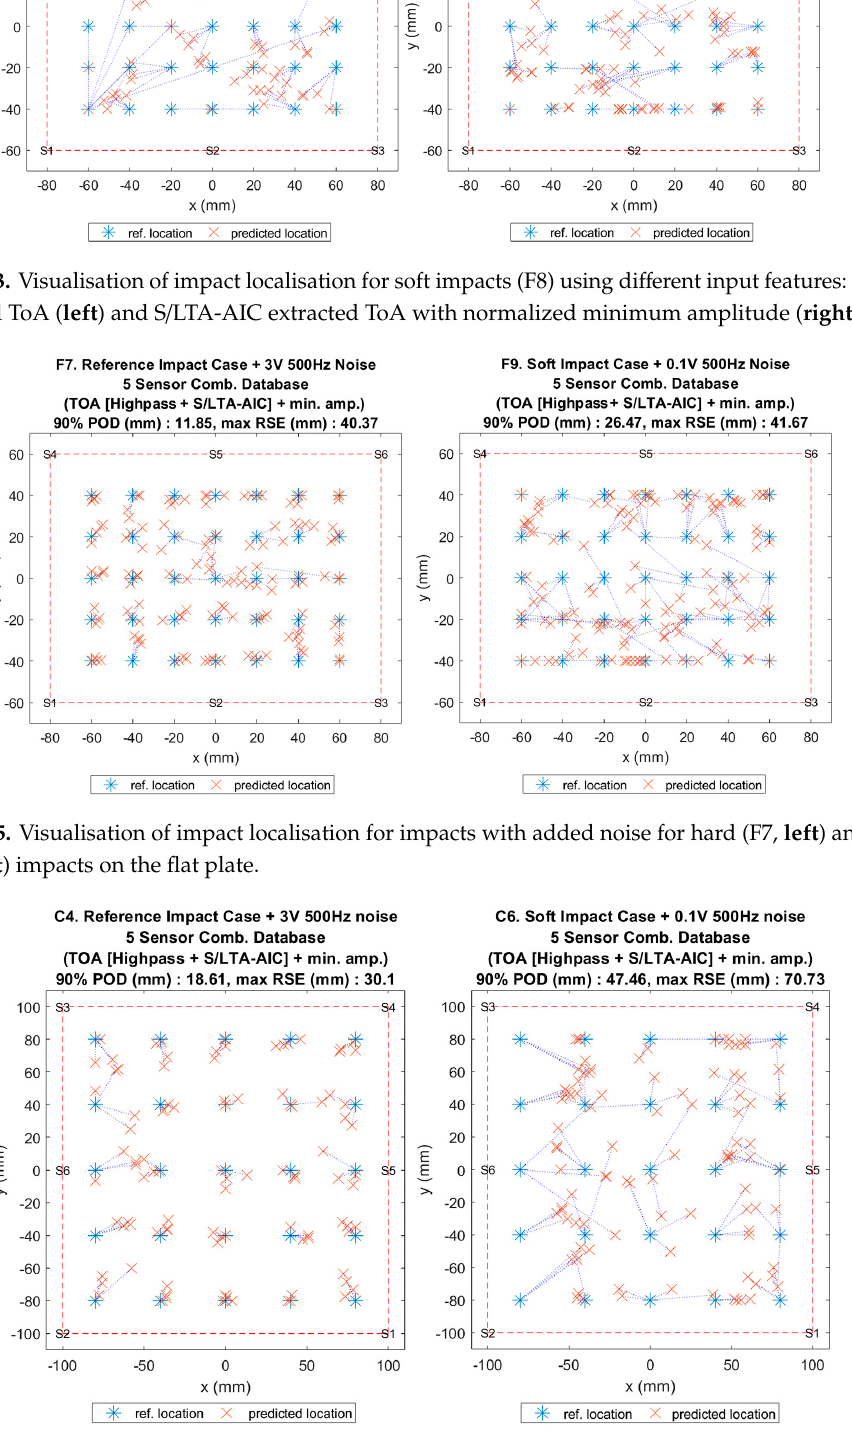
Figure 17. Visualisation of impact localisation for impacts with added noise for hard (C4, left) and soft (C6, right) impacts on the curved plate.